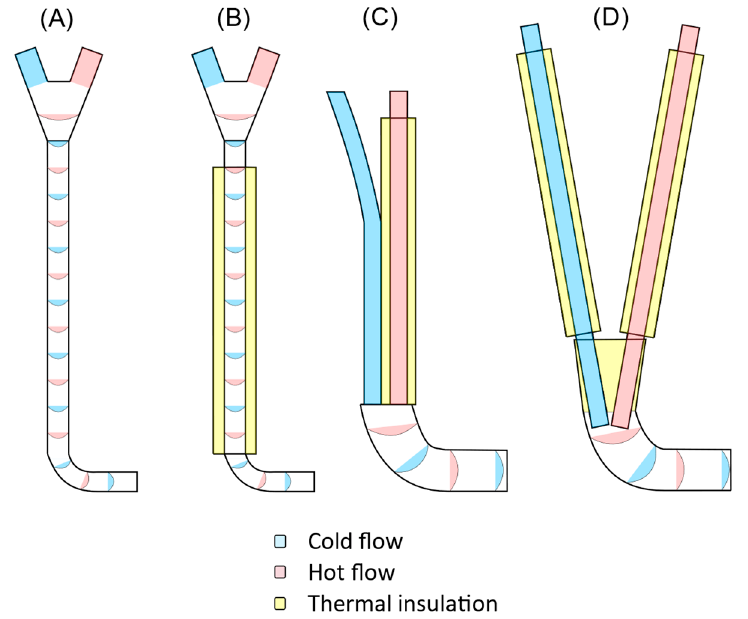
Figure 12. Different injector layouts. ( A ) layout A, ( B ) layout B, ( C ) layout C, ( D ) layout D.